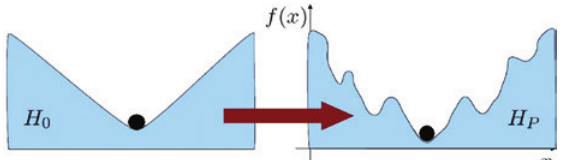
Figure 6: Adiabatic quantum computation. The energy landscape is first a simple one with one global minimum. It is then slowly deformed to create the desired land- scape. If this deformation is slow enough, then the system stays in the global minimum and does not get stuck in a local